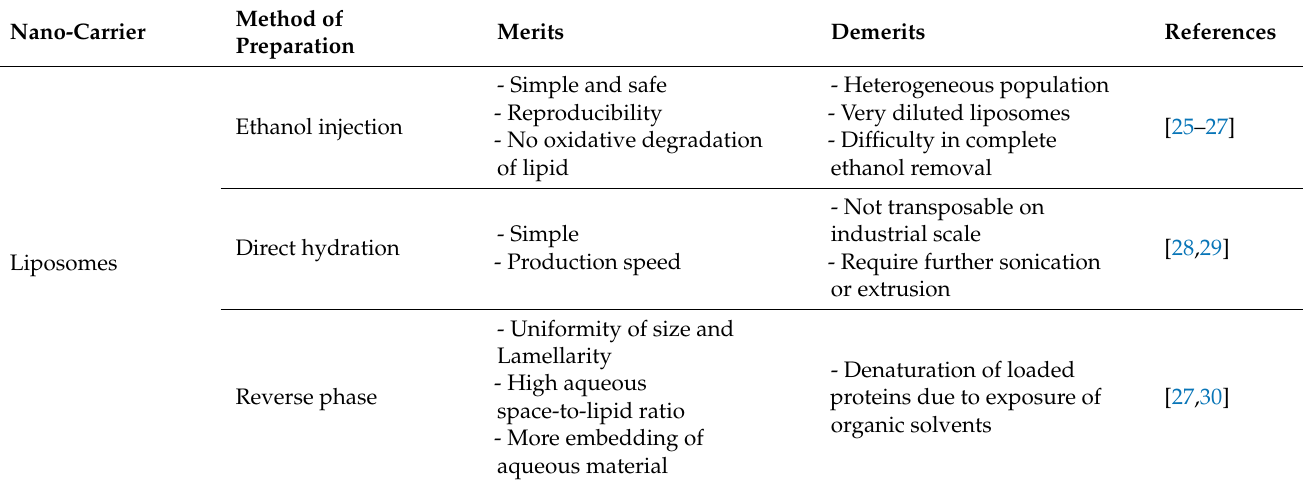
Table 1. Principal methods of lipid-based nanoparticle production together with their advantages and limitations.